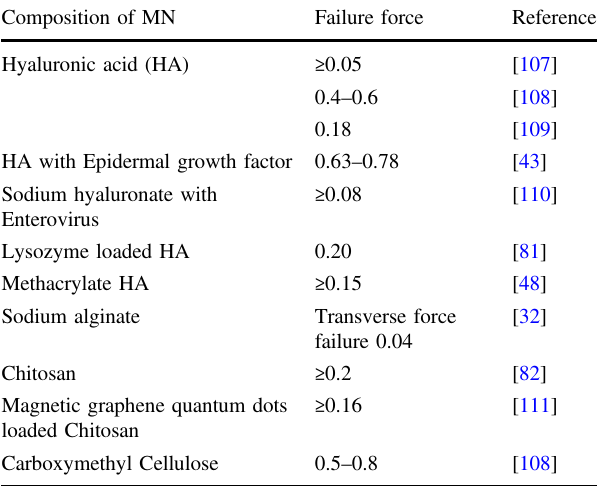
Table 3 Failure force after an axial force load of carbohydrates Composition of MN